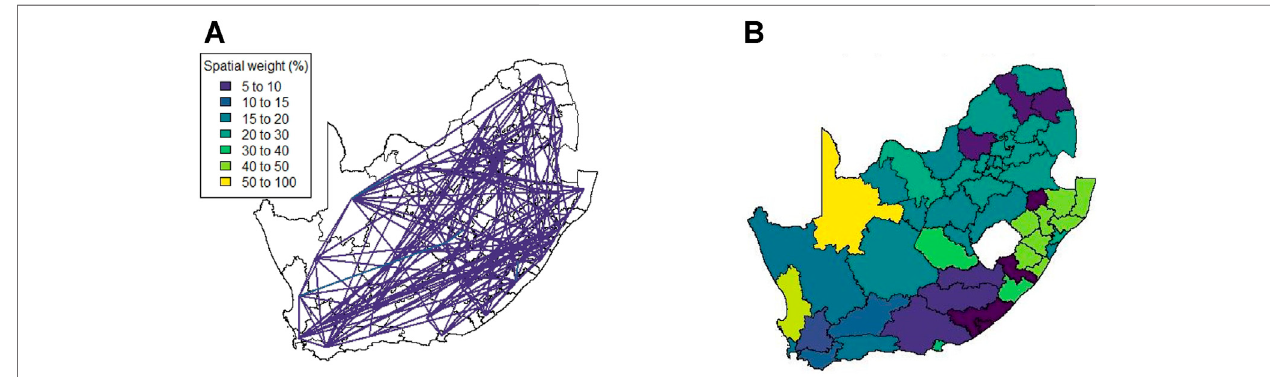
FIGURE 5 | Method 1 (A) Spatial weights (weights ≤ 5 not shown), (B) Complete linkage clustering (14 clusters indicated by colours).